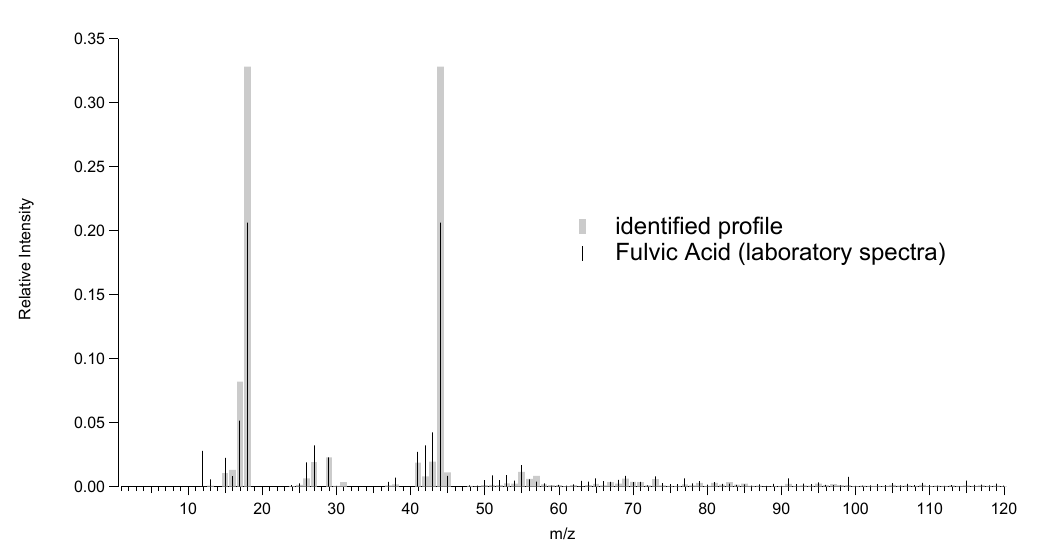
Figure 12. Mass spectra of the organic fraction obtained from snow re-suspended